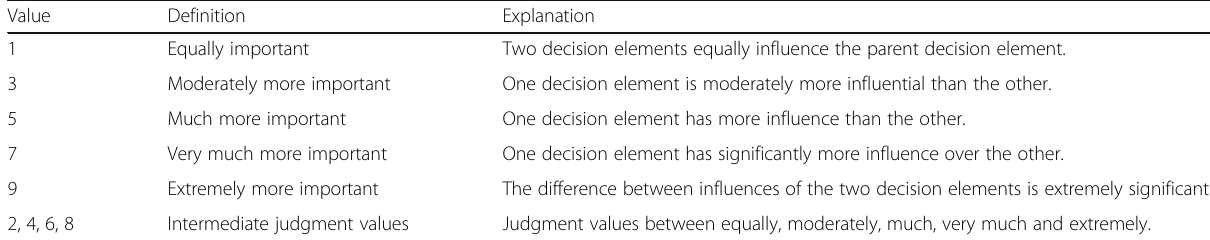
Table 2 Fundamental scale of Saaty